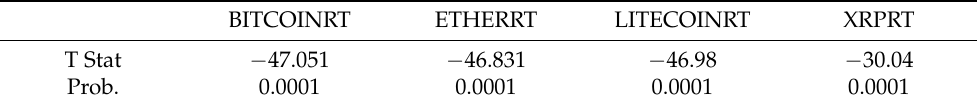
Table 5. Unit root